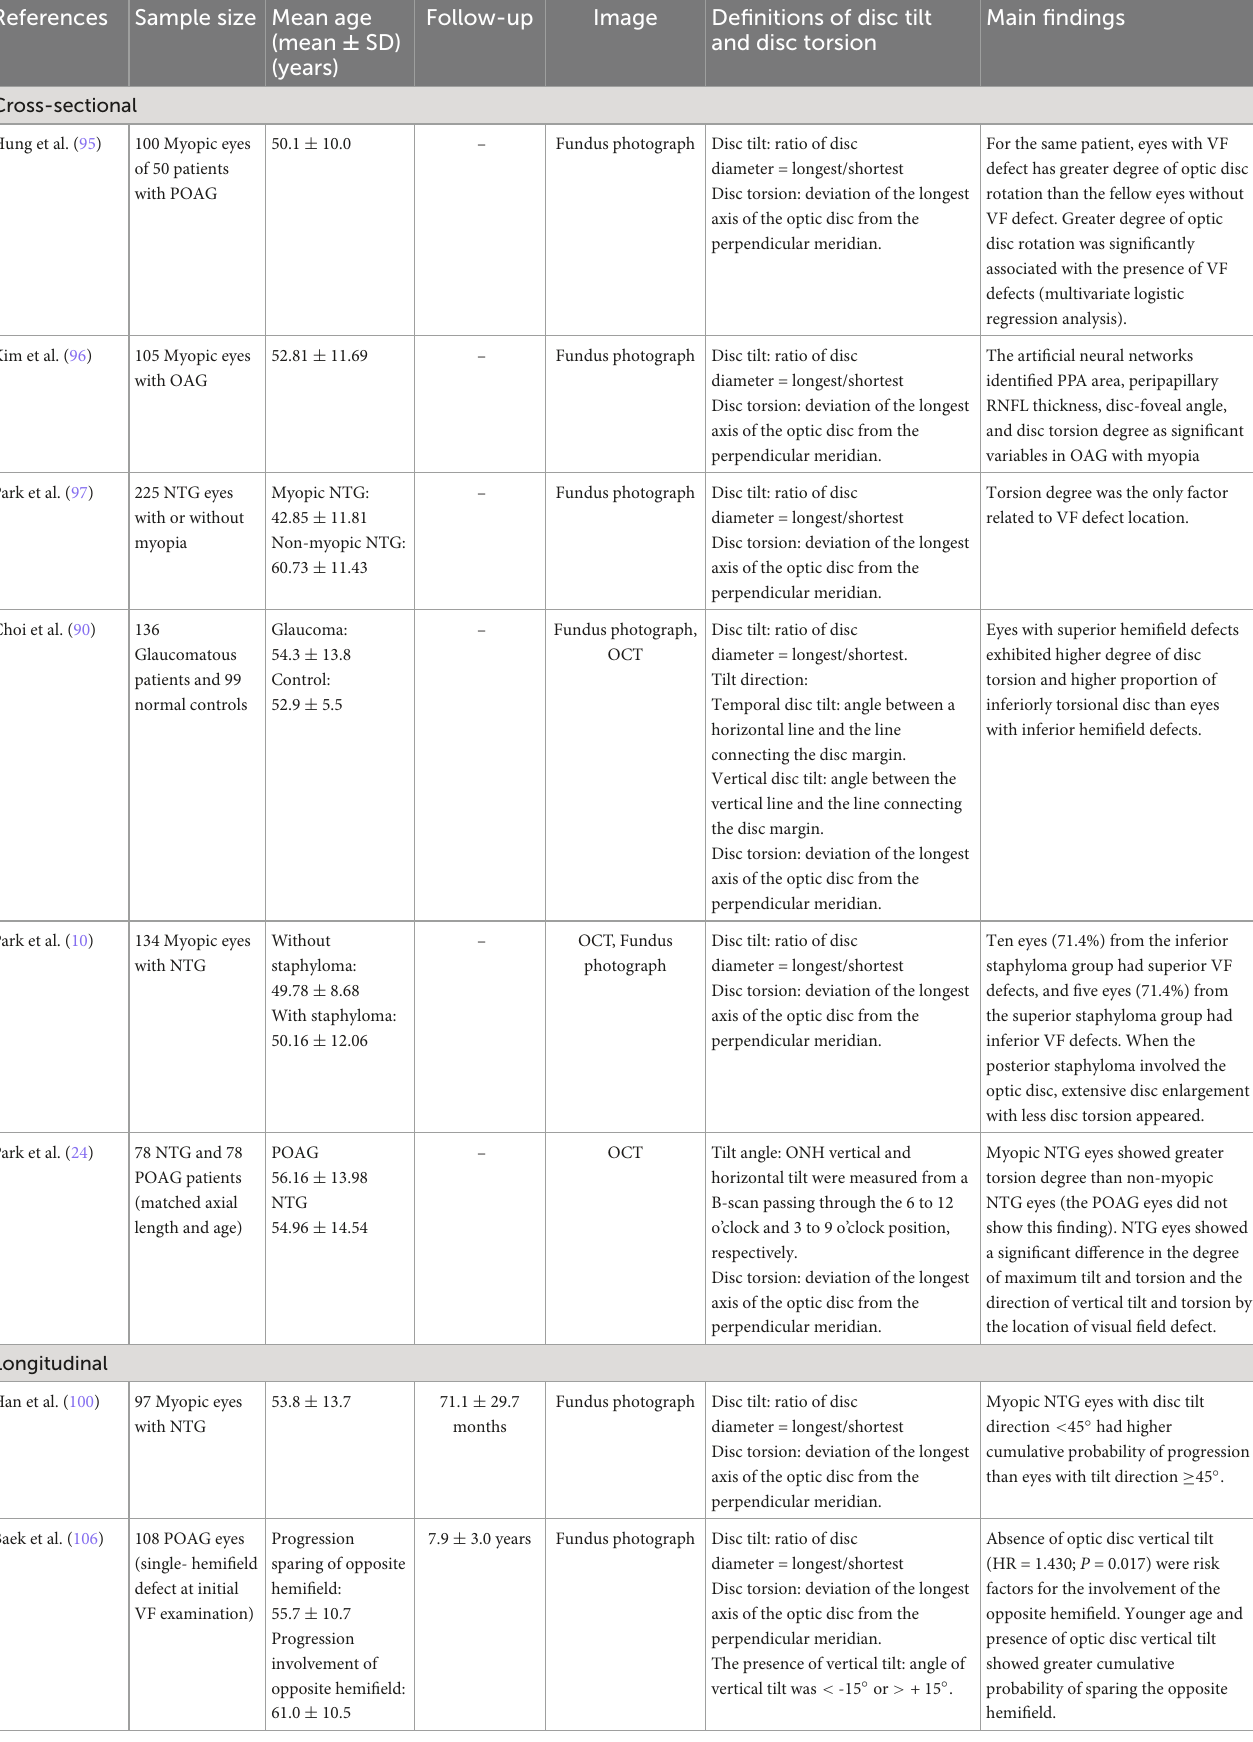
TABLE 3B Functional change in related to disc